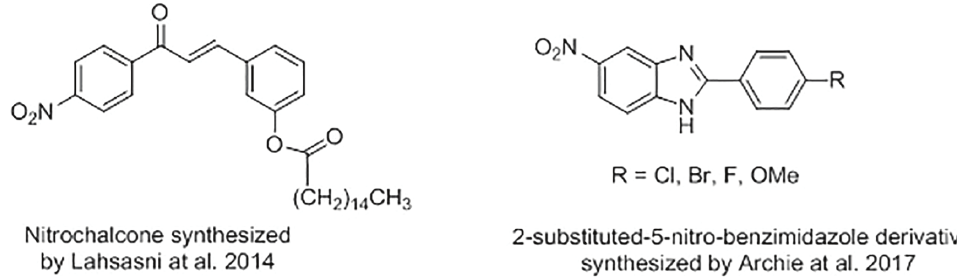
FIGURE 2 - Examples of nitro compounds with antioxidant